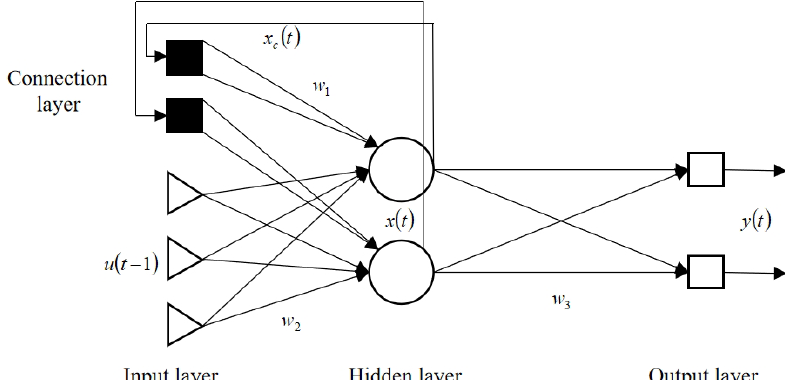
Figure 7. The structure of a BP neural network.